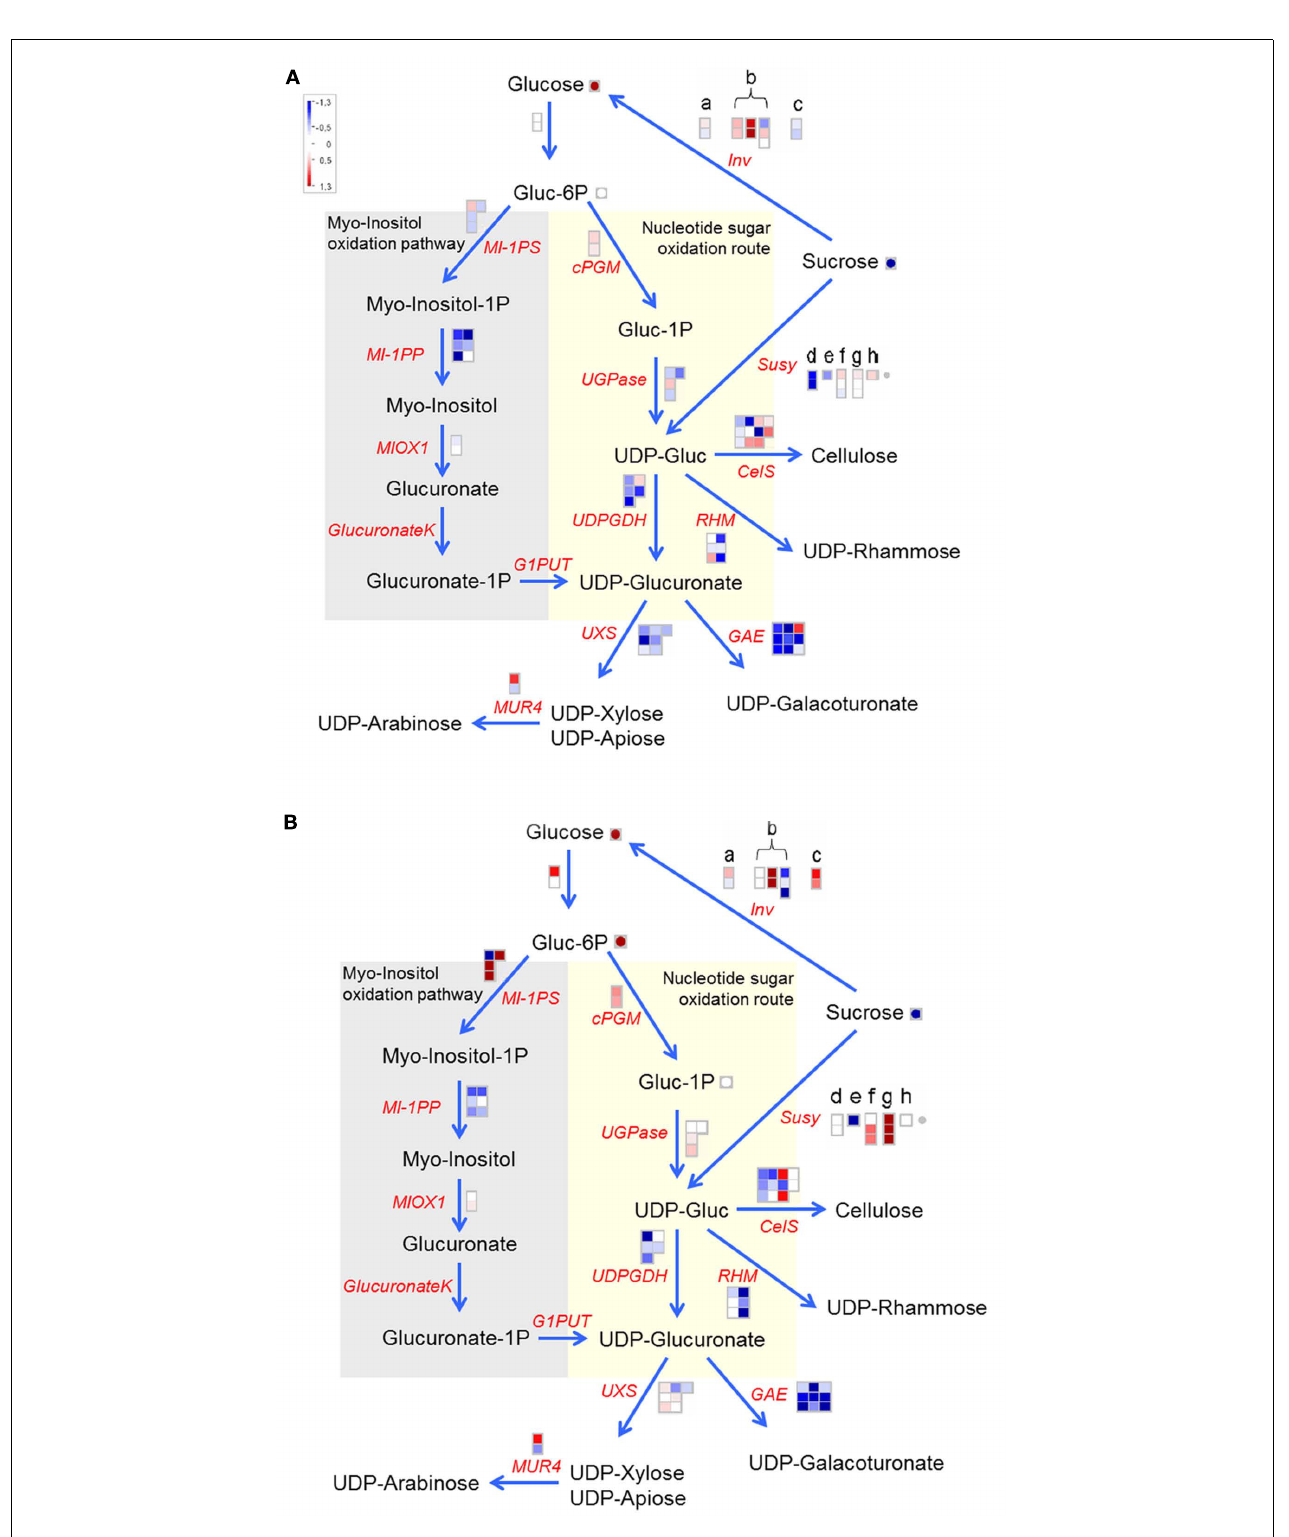
Myo-inositol-1-phosphate phosphatase; Glucuronate K, glucuronate kinase; G1PUT, galactose-1-phosphate uridylyltransferase; UXS, UDP-xylose synthase; GAE, UDP-glucuronate epimerase; RHM, rhamnose synthase; CelS, cellulose